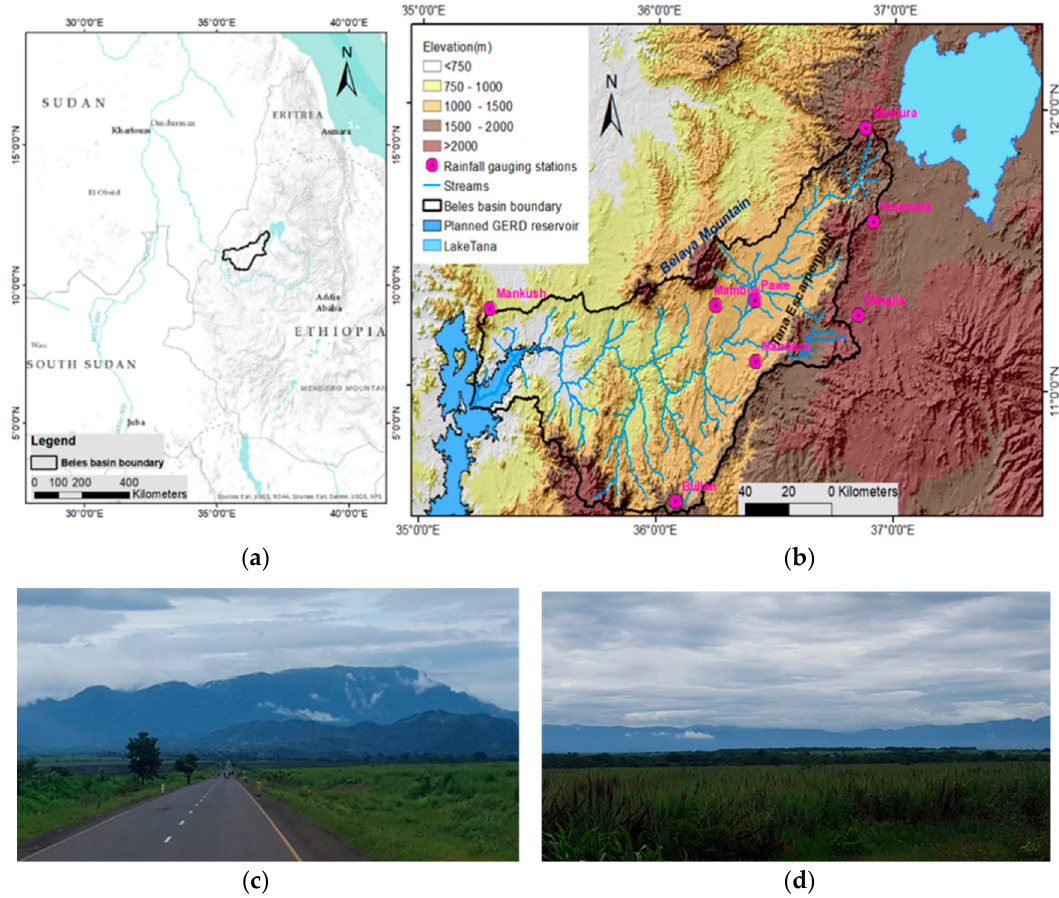
Figure 1. Location ( a ) and physiography of the Beles Basin, with rainfall gauging stations and surrounding areas of the Beles Basin ( b ) with 30 m resolution Digital Elevation Model from the Shuttle Radar Topographic Mission (SRTM) as a hillshade background. Lower photos show different landscapes in the basin; Belaya mountain ( c ) and Tana escarpment ( d ).